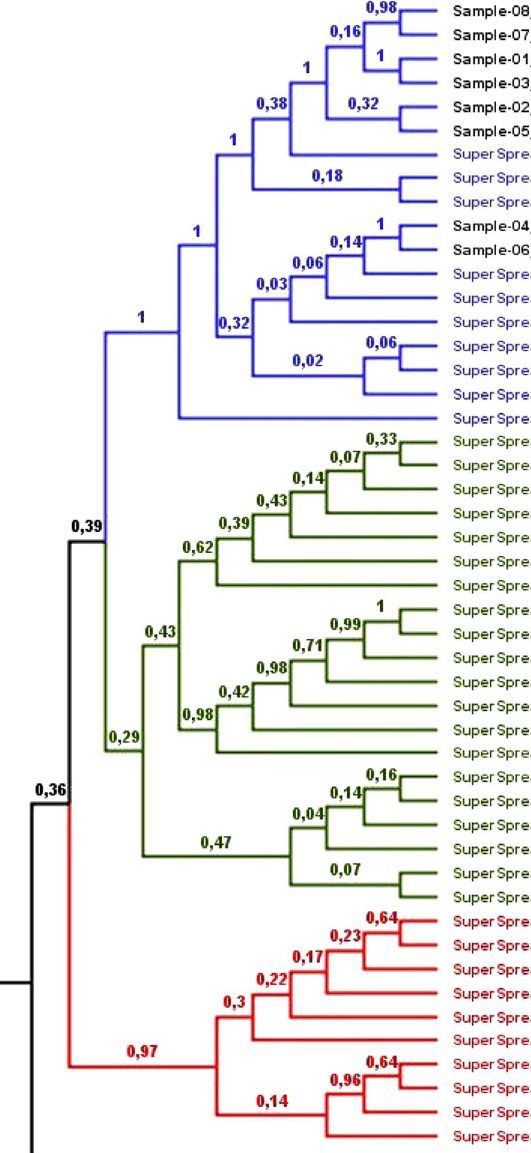
Figure 2. Bayesian phylogenetic analysis to determine evolutionary group. In the generated MCC tree, the phylogenetic relationship was estimated from 49 SARS-CoV-2 sequences included in dataset A. The red taxa correspond to the SS1 group; groups SS2 and SS3 are in green, mixed as previously proposed and; the SS4 group is in blue. The study samples are colored black, as well as the sequence used for rooting the inferred tree. In each node, the subsequent probability rate for supporting the branches in decimal data is shown. The time for the most recent common ancestor (tMRCA) among all variations of SARS-CoV-2 was dated to October 23, 2019 (95% Highest Posterior Density—HPD: July 29 and December 17, 2019), similar to other studies 49–51 , which shows the accuracy of the molecular clock addressed in the present